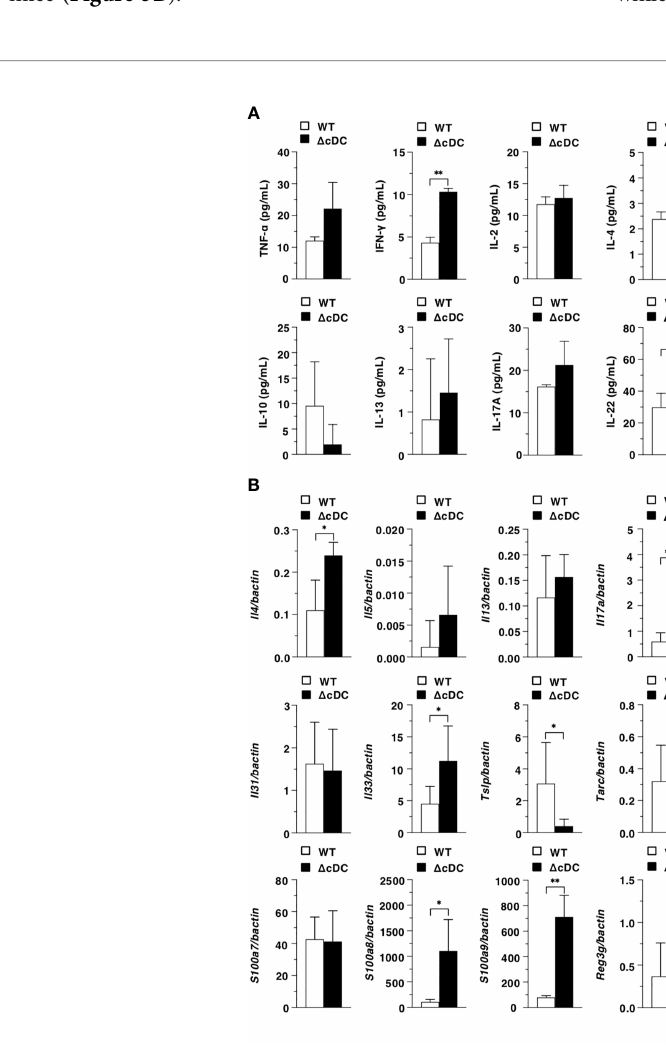
FIGURE 3 | Constitutive loss of cDCs enhances the AD-associated in fl ammation. (A) Serum production of cytokines in WT mice and D CD11c hi cDC mice (n = 4 per group) at 16 days after topical application with MC903. Data are obtained from four individual samples in a single experiment. (B) Transcriptional expression of in fl ammation- and epithelium-related molecules in ear skin obtained from WT mice and D CD11c hi cDC mice (n = 9 per group) at 16 days after topical application with MC903. Data are obtained from nine individual samples in a single experiment. * P < .05, ** P < .01 compared with WT mice by two-sided paired student t -test. All data are representative of at least 3 independent